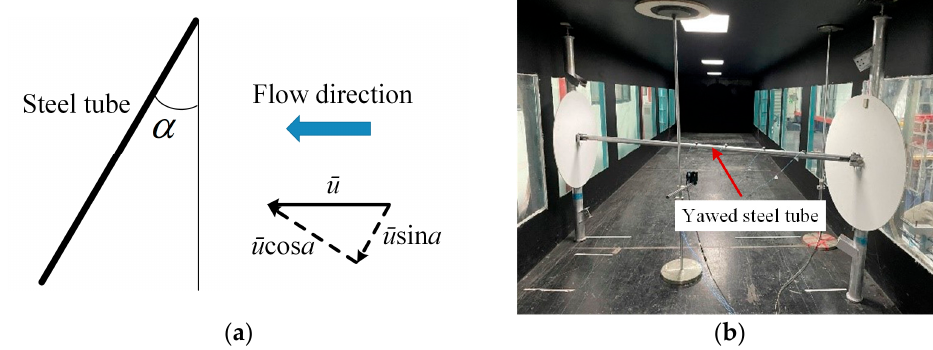
Figure 4. Definition the yaw angle and yawed steel tubes. ( a ) Definition the yaw angle (top view); ( b ) Yawed steel